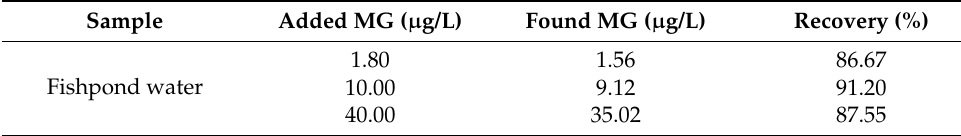
Figure 5. SERS spectra of ( A ) MG and ( B ) CV adsorbed on the Au NRs@TiO 2 substrates (a, c, e), and the repeating cleaning and recovery (b, d) processes for three cycles.